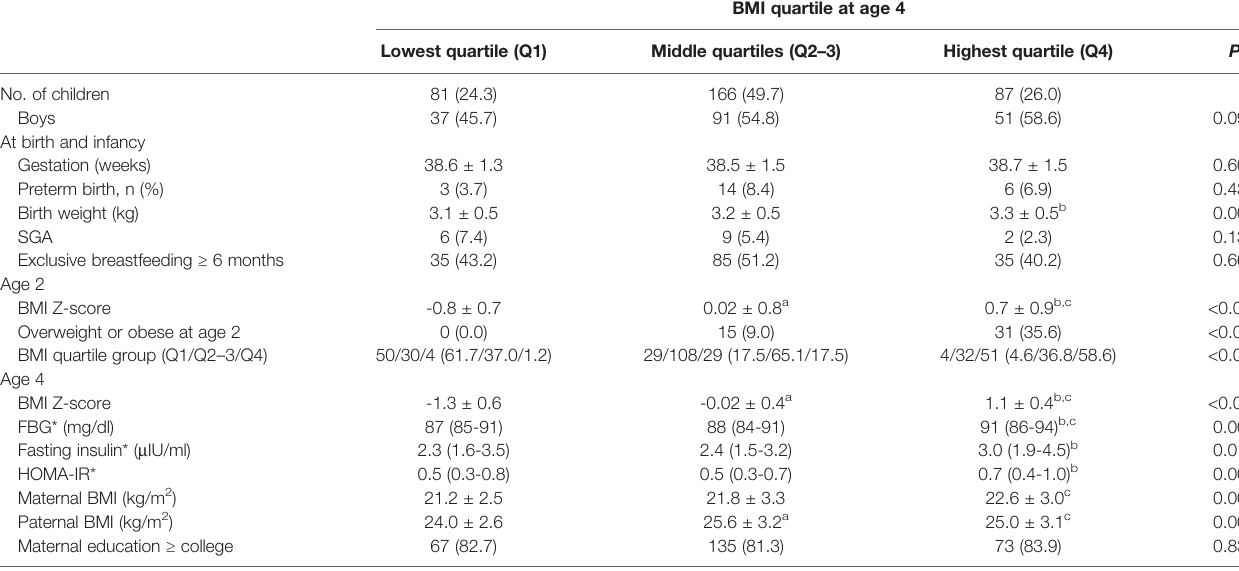
TABLE 2 | Comparison of characteristics between BMI Z-score quartiles at age